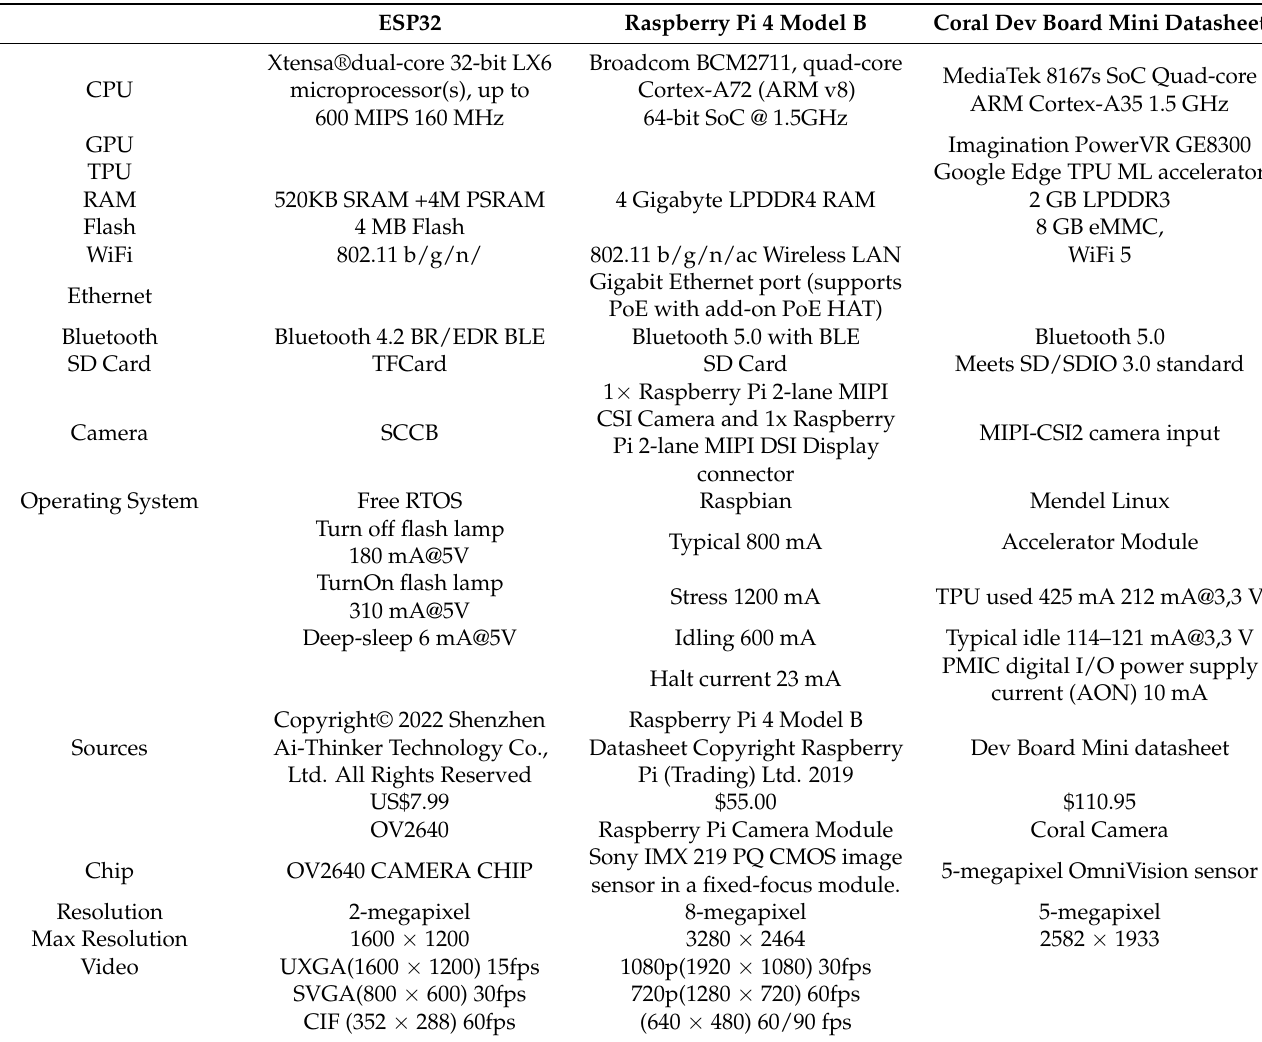
Table A1. Technical specifications of the hardware platforms compared in this work. The cost is indicative